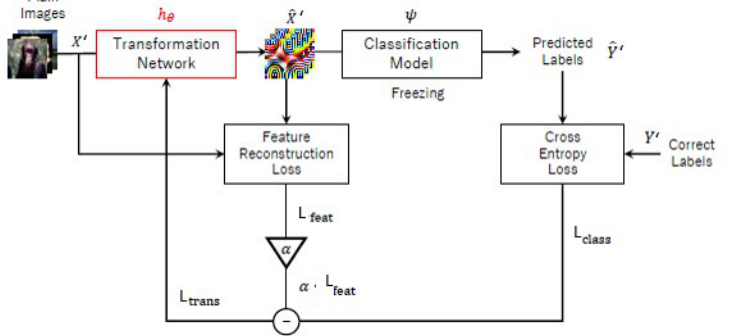
Figure 5. Training process of the transformation network in the TN-model-based method. © 2020 IEEE. Reprinted, with permission, from